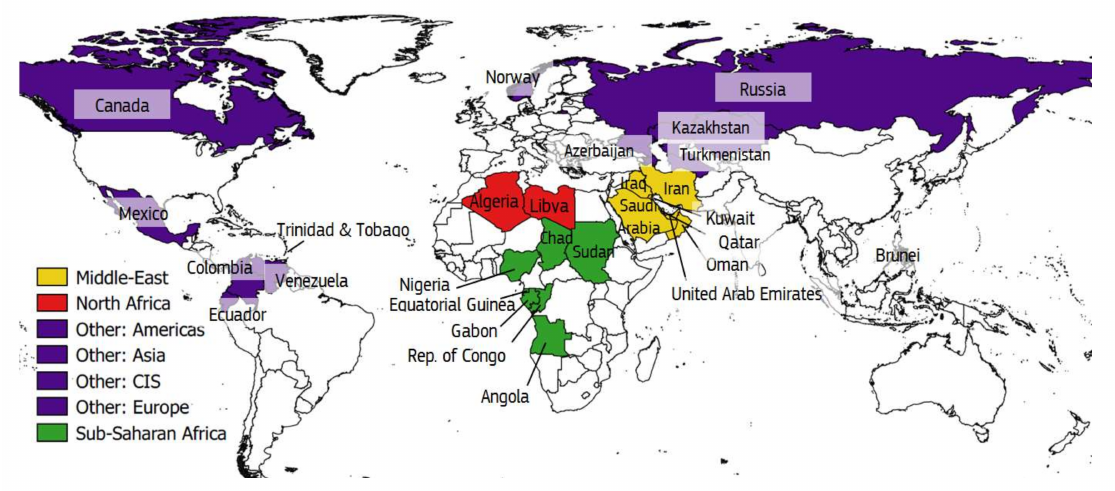
Figure 3. Map of oil exporting countries (2014).